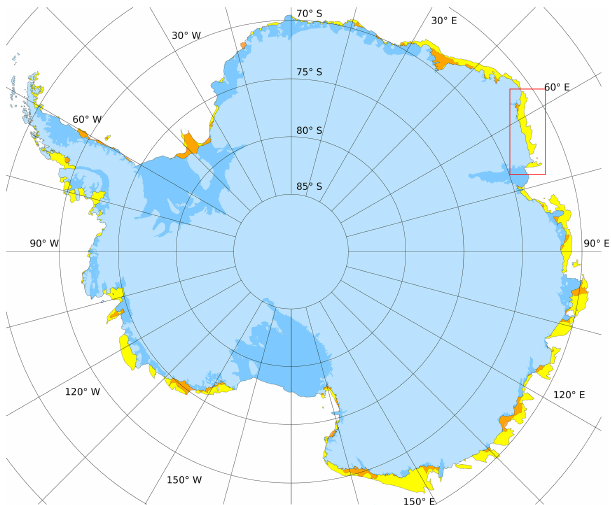
Figure 3. Fast-ice distribution at times of maximum (occurring in 2006, DOYs 271–285; shown in yellow) and minimum (2009, DOYs 061–075; shown in orange) extent over the 18-year dataset period. The grounded Antarctic Ice Sheet and floating ice shelves are shaded light and dark blue, respectively. The red rectangle shows the region used to illustrate the automation in Fig.